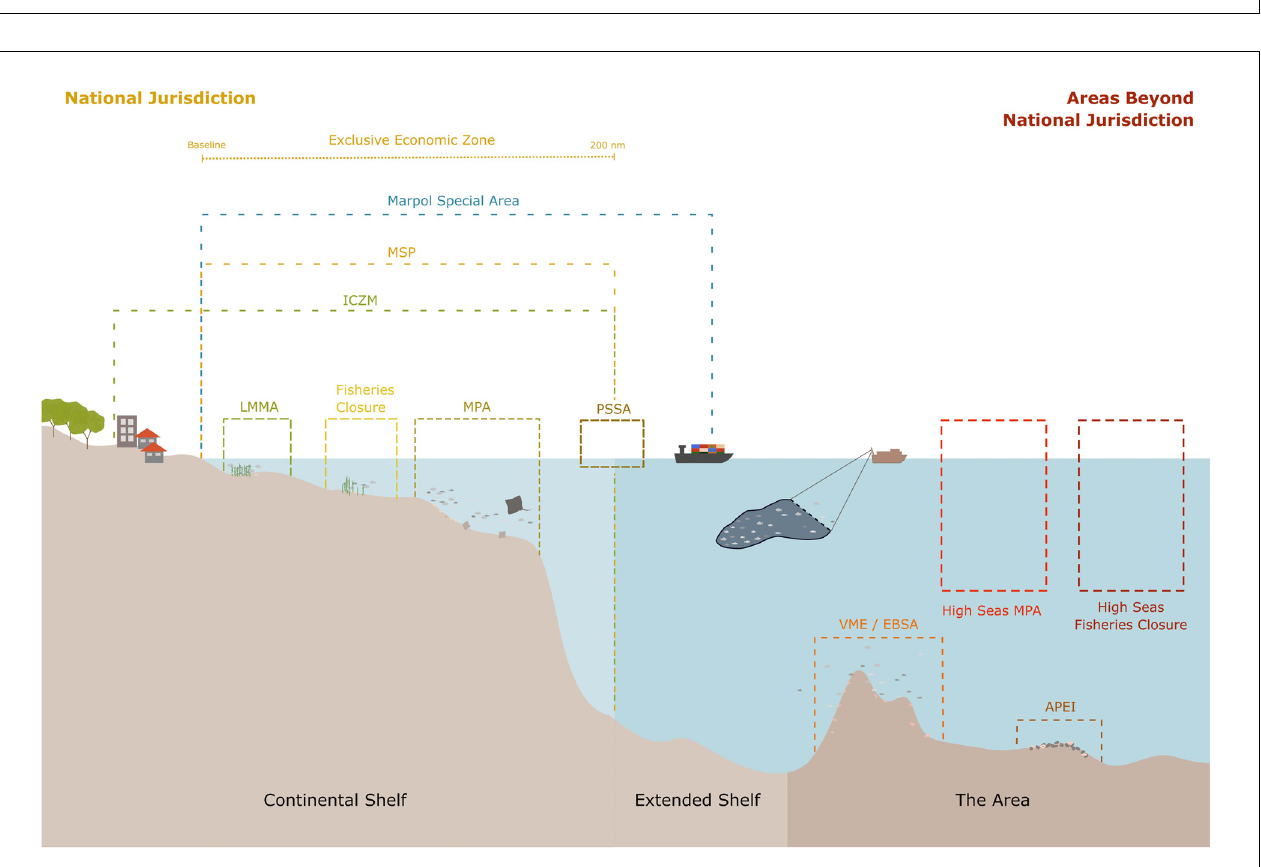
Frontiers in Marine Science |